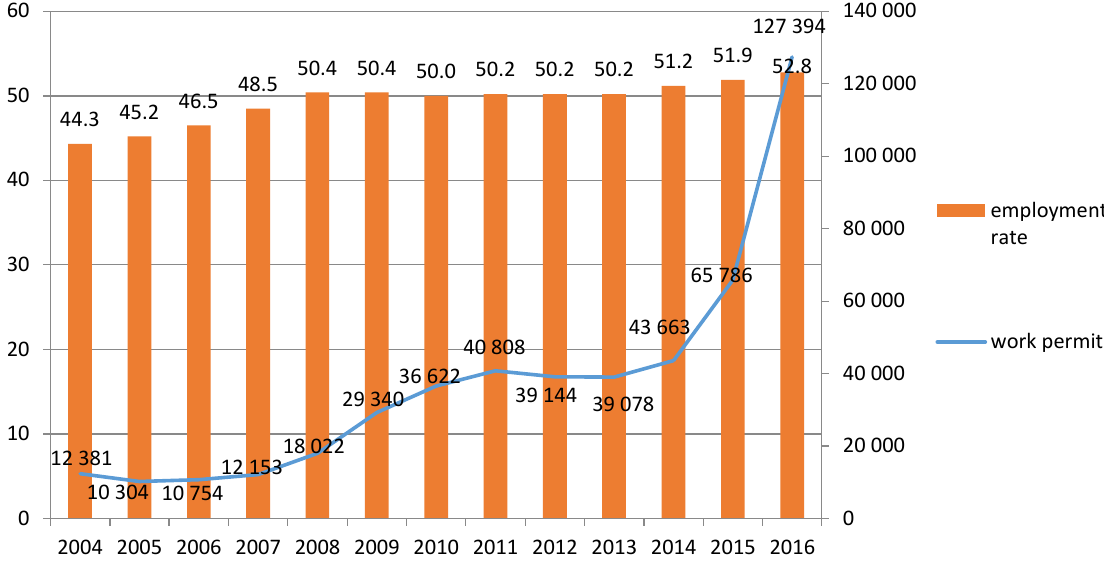
Source: CSO (2017a) and Ministry of Family, Labour and Social Policy